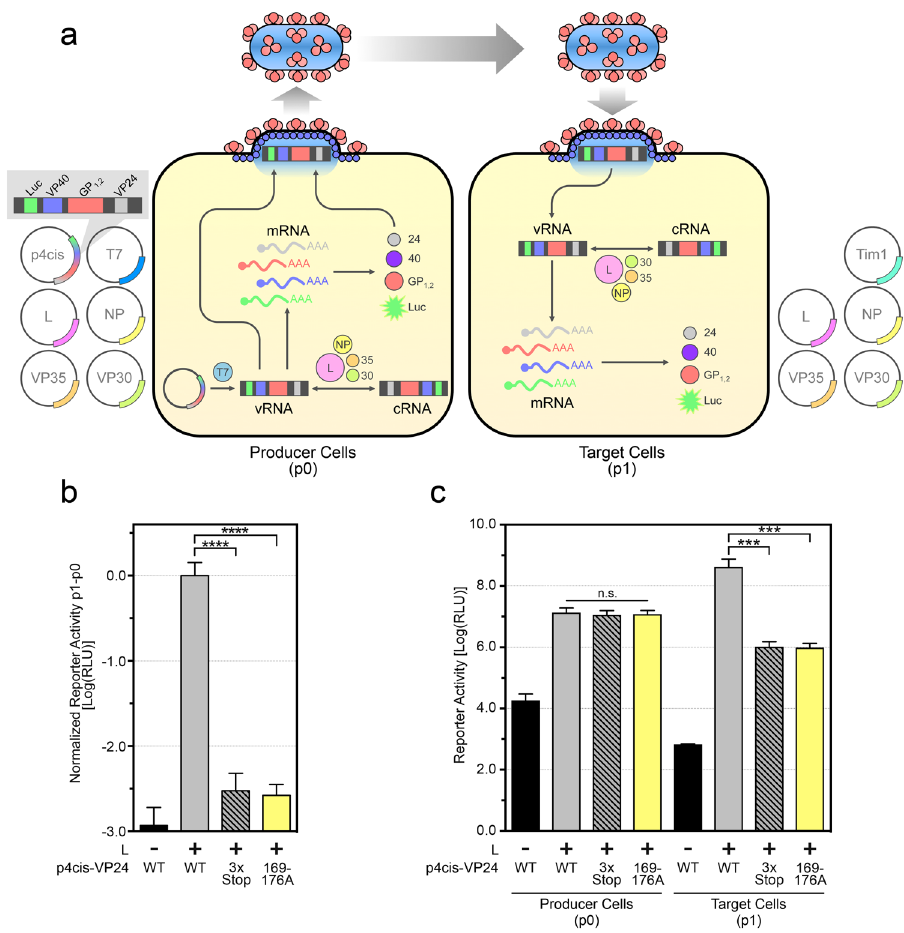
Figure 3. VP24 169–176A does not support trVLP production. ( a ) A schematic of the EBOV transcription/ replication-competent virus-like particle (trVLP) assay. In producer cells (p0), initial transcription of the tetracistronic minigenome (4xMG) by the T7 polymerase produces a viral RNA (vRNA) template, which is then replicated, via complementary RNA (cRNA) intermediates, by the EBOV ribonucleoprotein complex, consisting of L, NP, VP35, and VP30. From the minigenome, the ribonucleoprotein complex also transcribes Renilla luciferase, VP40, GP 1,2 , and VP24 mRNA, which is then translated by host cellular machinery. NP encapsidates the vRNA, along with VP35, VP30, VP24, and L, and the nucleocapsids interact with the matrix protein VP40 and the glycoprotein GP 1,2 , to form trVLPs. trVLPs are capable of infecting target cells (p1) pre- transfected with the EBOV ribonucleoprotein complex and mounting a second round of replication. Renilla luciferase signal in producer cells is proportional to EBOV minigenome replication and transcription, and in target cells it is additionally proportional to the amount of trVLPs produced and capable of infecting target cells. Notably, VP24 is required for the production of infectious trVLPs. ( b , c ) HEK 293T producer cells were co-transfected with p4cis-vRNA-RLuc (p4cis), encoding wild-type (WT) VP24, VP24-3x-stop, or VP24 169– 176A, as well as pCAGGS-luc2, encoding Firefly luciferase as a transfection control, pCAGGS-T7, pCAGGS-L, pCAGGS-NP, pCAGGS-VP35, and pCAGGS-VP30. trVLPs in the supernatant were harvested and used to infect HEK 293T target cells pre-transfected with pCAGGS-Tim1, pCAGGS-L, pCAGGS-NP, pCAGGS-VP35, and pCAGGS-VP30. Data are presented as relative light units (RLU) on a log scale with the Renilla luciferase signal in target cells (p1) minus the Renilla luciferase signal in producer cells (p0) normalized to WT VP24 ( b ) or with the Renilla luciferase signals in producer (p0) and target cells (p1) indicated separately ( c ). The Renilla luciferase signal in producer cells was normalized against the average Firefly luciferase signal. The means and standard error of the mean for 3 independent experiments are shown (n.s., not significant; *** p ≤ 0.001; **** p ≤